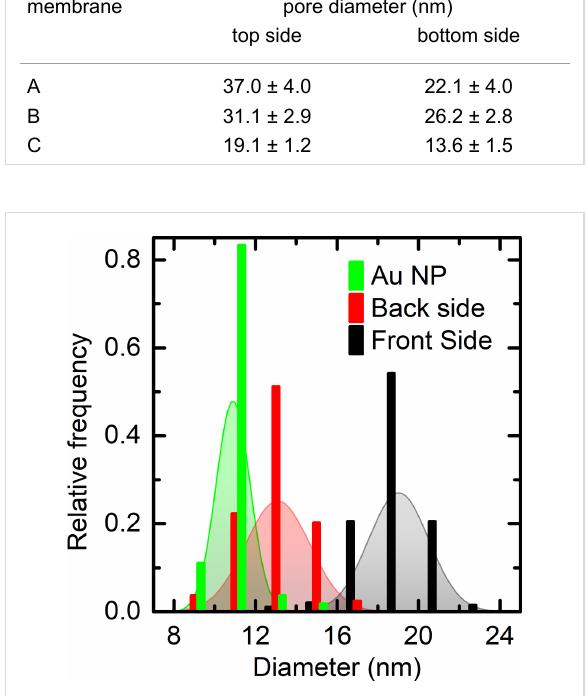
Figure 3: Diameter distributions for the Au NP etch mask (green) and the resulting nanopores of membrane C on the front side (black) and on the back side (red). Vertical bars represent experimental data to which the shaded Gaussians were fitted.